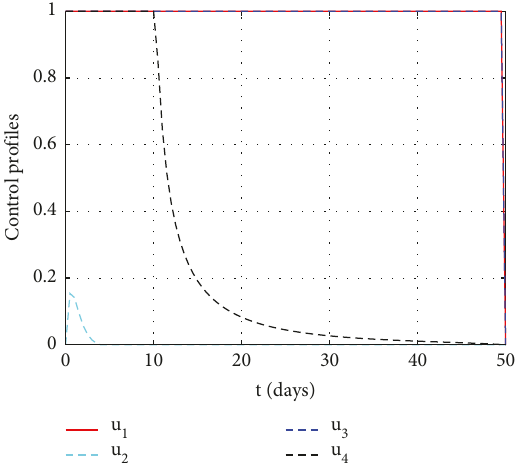
Figure 10: Simulations of control measures effects on controlling status.